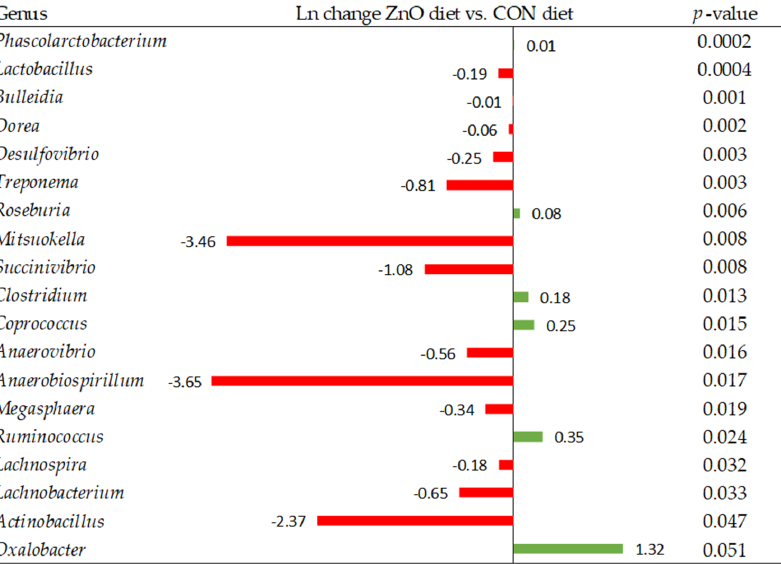
Figure 5. Nonmetric dimensional scaling (NMDS) plot of dissimilarity matrix based on Bray–Curtis distance clustered (PADONIS = 0.023).